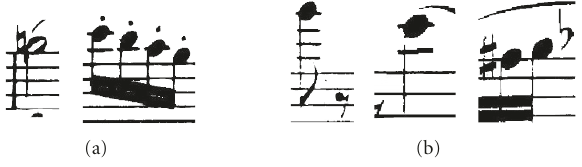
Figure 3: Examples of common printing defects: symbols touching (a), fragmented or damaged symbols (b).